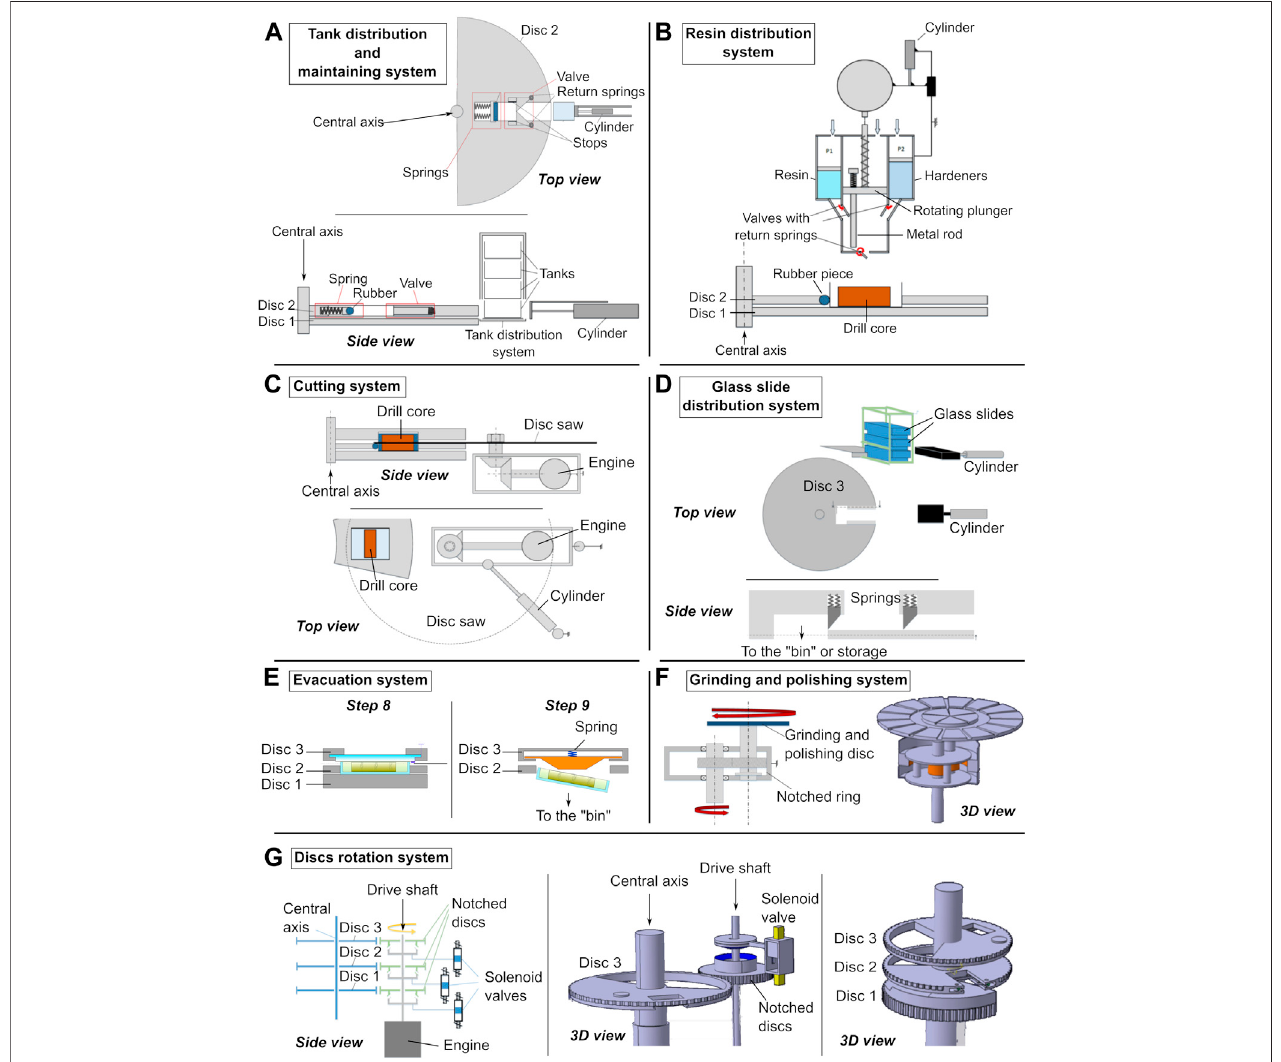
FIGURE 12 | Possible LithoSpace system improvements. (A) Tank distribution and maintaining system. In this solution, the induration tanks are stored in a column located on the side of the discs in such a way that the bottom tank is aligned with disc 2. A cylinder is used to push the tank within the empty mould in disc 2 where it is maintained between a valve composed of two stops fi xed with return springs and a rubber piece mounted on springs. (B) Resin distribution system. The solutionproposedpermitsthemixingoftheresinanditshardener.Acylinderisusedtopushthetwocomponentsdownintoatankwheretheyaremixedusing a metal rod fi xed on a rotating plunger that turns and moves down. The system is designed in such a way that the correct quantity and ratio of resin/hardener is reachedwhentheplungerreachesthevalvesoftheresinandhardenertanks.Theplungerispusheddowntoitsmaximumtoexpelthemixedresin/hardenermixture onto the drill core in the induration tank. (C) Cutting system. In this system, the disk saw is driven using an engine and moved to the cutting position using a cylinder. The sawing of the sample is carried out by moving the sample on the disc saw by rotation of the 3 discs. (D) Glass slide distribution system. The glass slides are thinned on their edges so that they can be inserted into grooves and moved horizontally within the disc 3. They are pushed using a cylinder and maintained by two stops fi xedonsprings.Whenanotherslideisinserted,itpushesawaythepreviousonewhichfallsintothe “ bin ” oranotherstoragesystem. (E) Evacuationsystem.In order to remove the samples from disc 2, a moving section can be fi xed below disc 3 with a spring to push the samples down. (F) Grinding and polishing system. In order to avoid polishing streaks on the surface of the thin sections it is proposed to used double axis rotation to create a loop movement. This method is commonly usedinstandardpolishingorsandingdevices. (G) Discrotationsystem.Insteadofrotatingthediscfromthecentralaxis,itisproposedtoinducethemovementfrom theirside. Eachofthe 3discs is thus surrounded bya notched ringin contactwith rotating, notched rings. Therotationofthe notched ringsisinducedby acommon drive shaft activated by a solenoid